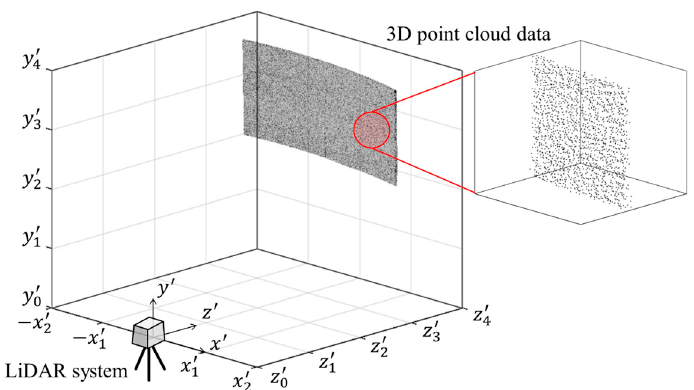
Figure 7. Original point cloud model of the test target.